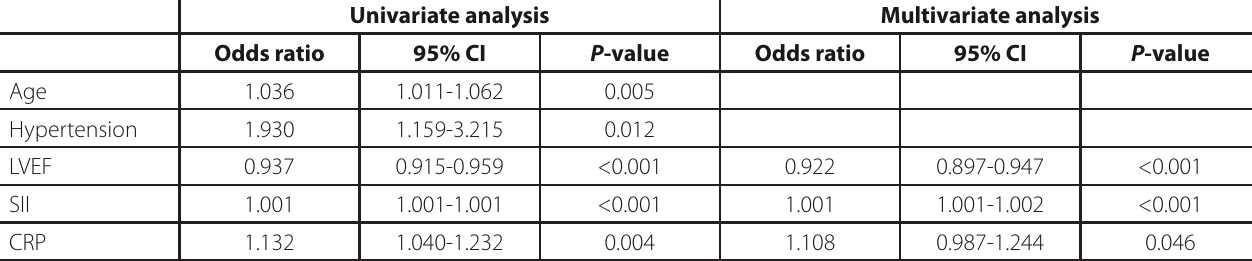
Table 3. Univariate and multivariate logistic regression analyses of independent parameters for atrial